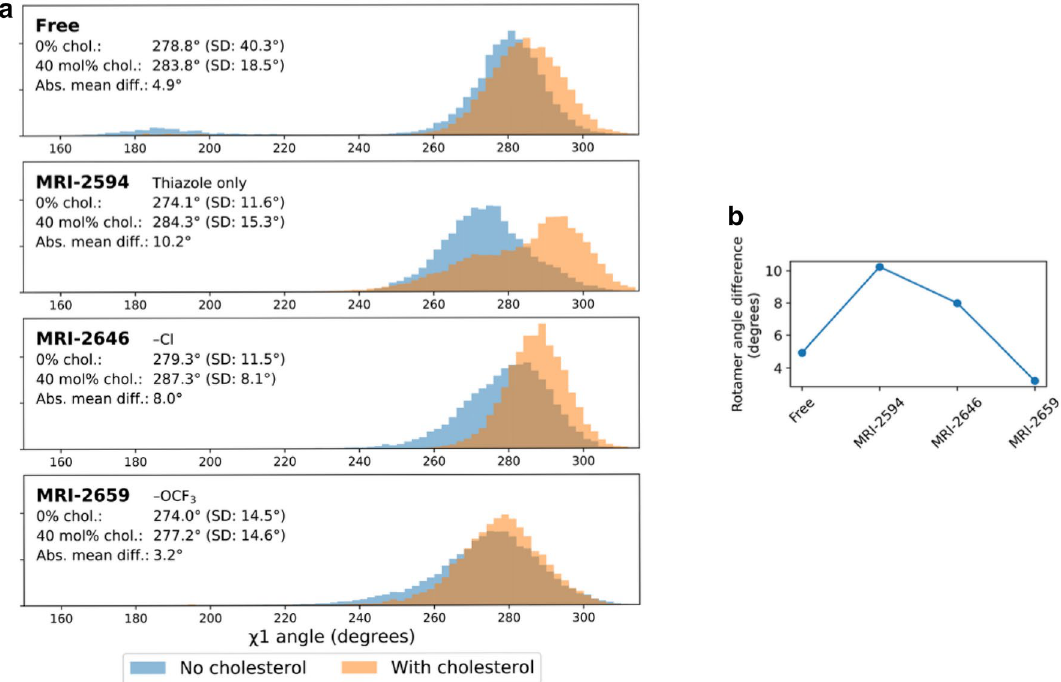
Figure 9. Difference in Trp258 6.48 rotamer angle related to presence of cholesterol. ( a ) Trp258 6.48 χ 1 rotamer angle distributions with 0% and 40 mol% cholesterol. ( b ) Difference in mean Trp258 6.48 χ 1 rotamer angle between no cholesterol vs 40 mol% cholesterol conditions; green (negative change) dashed line. TM domains are annotated, with up and down arrows indicating direction of helix, with up from intracellular to